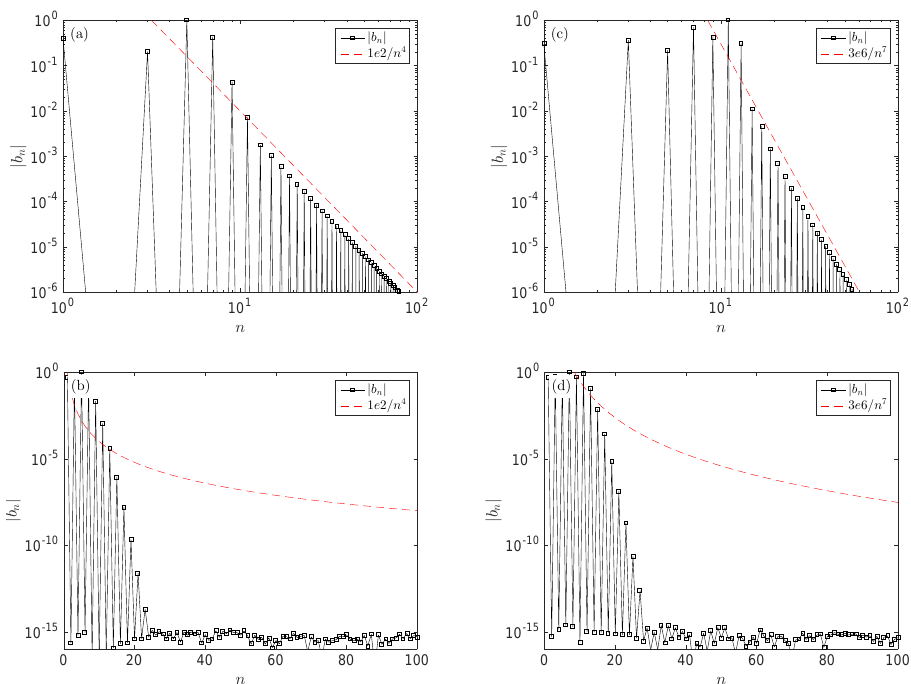
Figure 4. The absolute value of the expansion coefficients b n in Eq. (15), truncated at N = 150. The left panels are for the terdiurnal tides, s = 3, σ = 1 . 5, for eigenfunction with eigenvalue γ = 17.2098: (a) without parity factor, (b) with parity factor. The right panels are for pentadiurnal tides s = 5, σ = 2.5, for eigenfunction with eigenvalue γ = 22.9721: (c) without parity factor, (d) with parity factor. An empirical fitting curve is also shown in red dash.